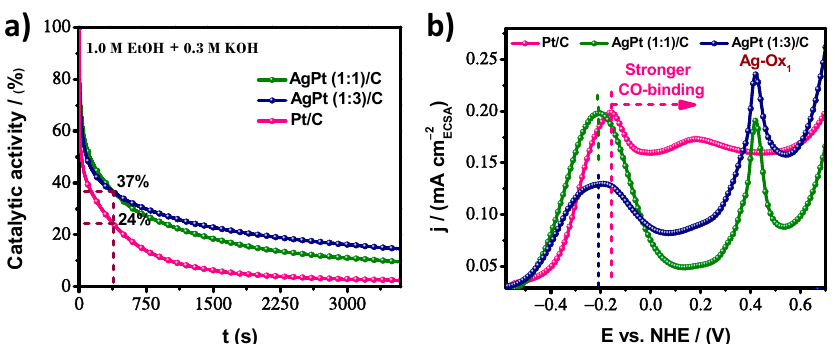
Figure 7. ( a ) Residual catalytic activity based on chronoamperometry (CA) measurement at − 0.25 V vs. Hg/HgO for ethanol oxidation reaction in alkaline media and ( b ) close-up on cyclic voltammo- grams curves in the anodic scan for AgPt (1:1)/C, AgPt (1:3)/C, and commercial Pt/C